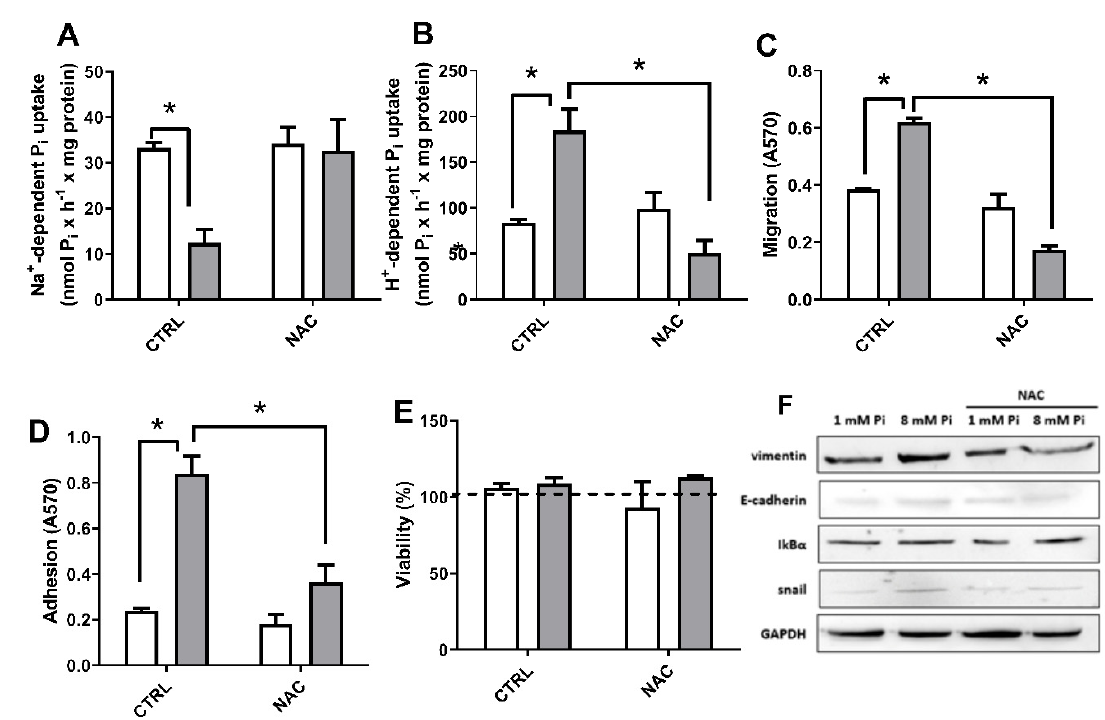
Figure 12. NAC effect on high Pi-induced Pi transport, migration, and cell adhesion to ECM in MDA-MB-231 cells. MDA- MB-231 cells were treated with 1 mM Pi (white bars) or 8 mM Pi (grey bars) in the absence (control) or presence of NAC (5 mM) for 24 h. Na + -dependent ( A ) or H + -dependent ( B ) Pi uptake was done for 1 h. Migration ( C ), adhesion to ECM ( D ), and cell viability ( E ) were performed as described in Section 4. Bars represent mean ± SE of at least three independent biological samples. * p < 0.05 indicates changes significantly different, as assessed by ANOVA followed by Tukey’s multiple comparison test. Representative immunodetections of, vimentin, E-cadherin, snail and IkB α in cells maintained at 1- or 8-mM Pi, in the presence or absence of NAC ( F ). GAPDH was used as loading control.